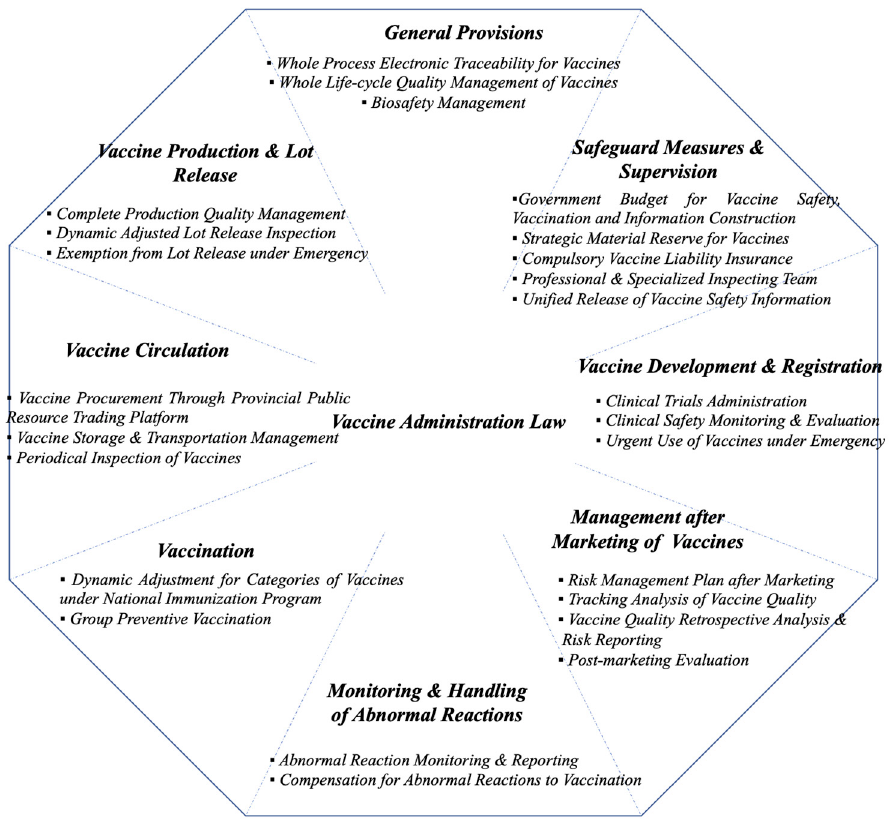
Figure 3. Organization of the Vaccine Administration Law .